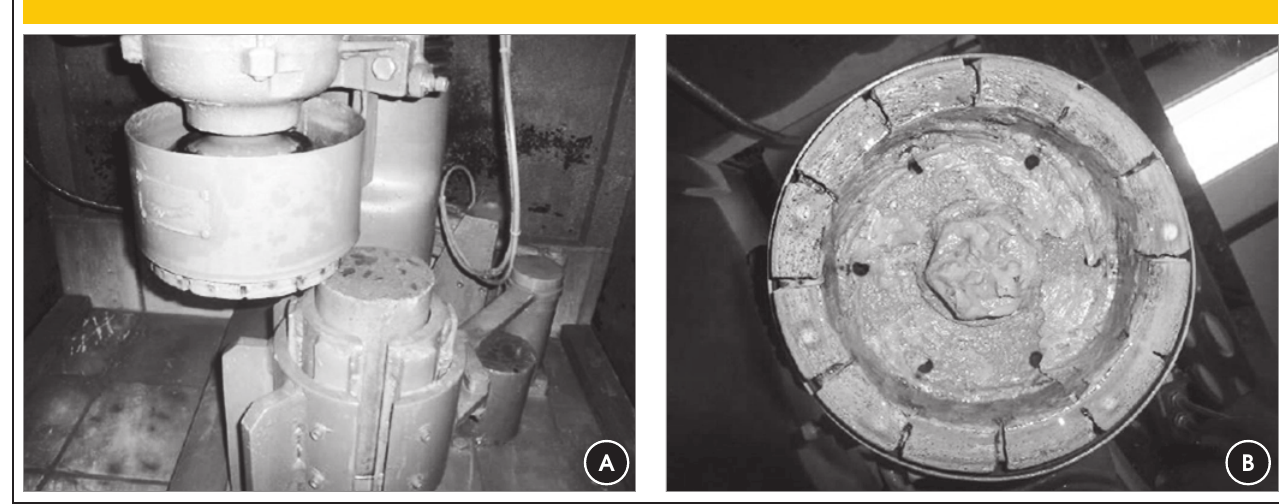
Figure 1 – Test specimen grinding with RRDR type grinder (B) and rigid diamond wheel